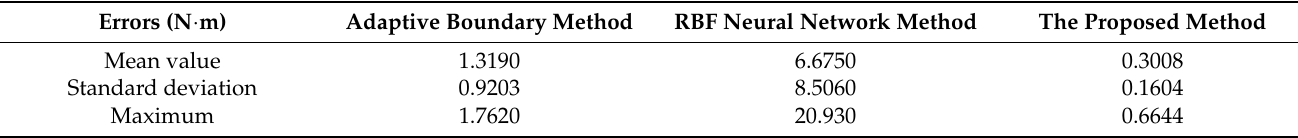
Table 3. The errors between experiment and three simulations.